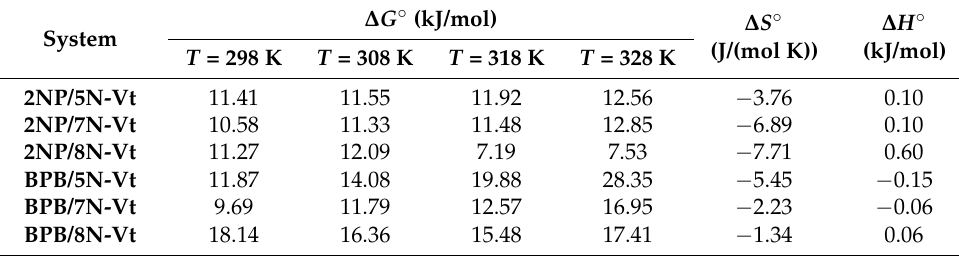
Table 5. Thermodynamic parameters for 2-NP and BPB for organo-Vts.